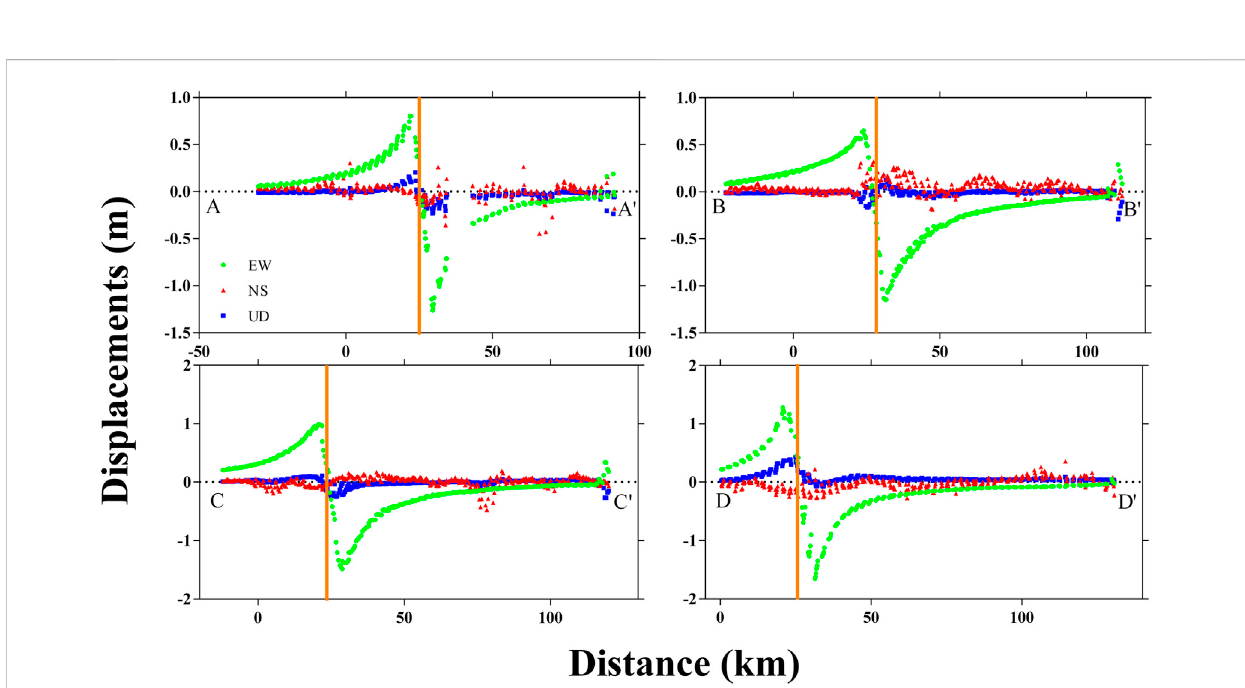
FIGURE 7 Cross section of 3D coseismic deformation fi elds. The EW (green circle), NS (red triangle), and UP (blue square) displacement components are corresponding to the four pro fi les. (A) , (B) , (C) , and (D) are associated with pro fi les AA ′ , BB ′ , CC ′ , and DD ′ respectively. The orange line represents the Jiangcuo